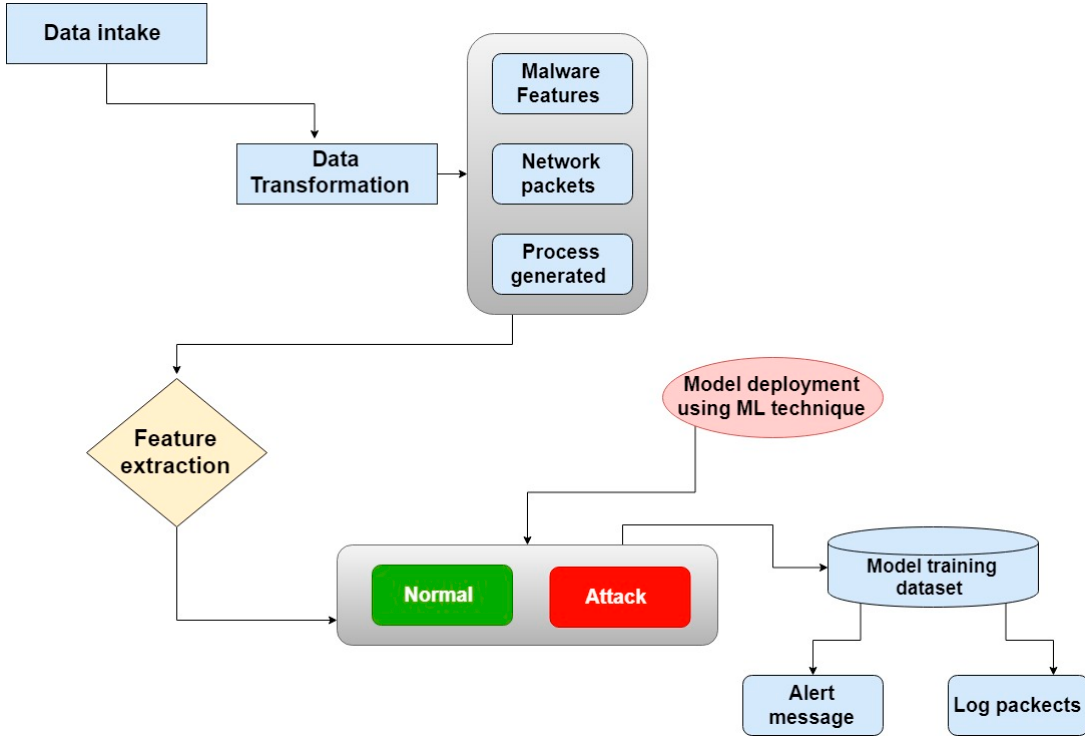
Figure 7. Schematic workflow of the proposed IDPS .